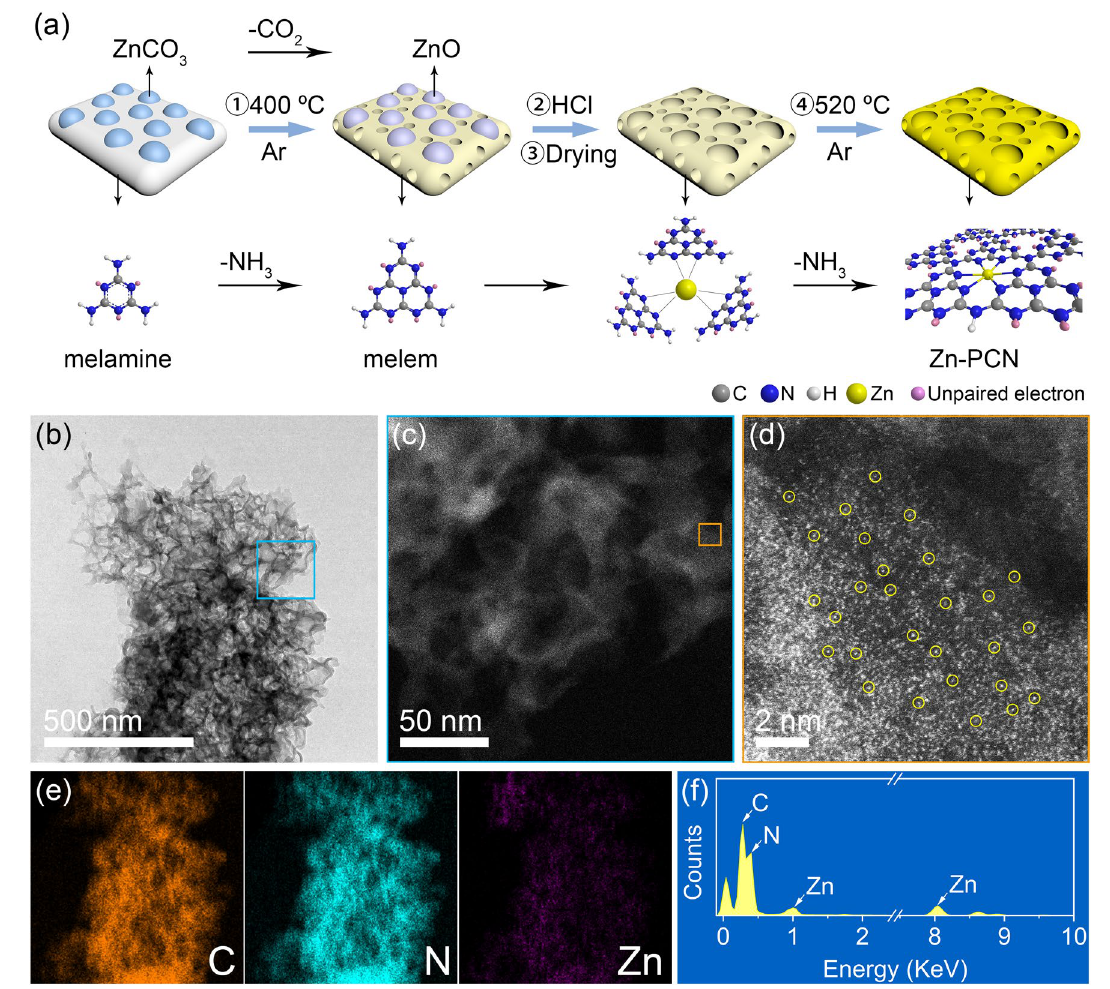
Fig. 1 a Schematic illustration of the synthesis of Zn‑PCN b TEM image of Zn‑PCN. Representative HAADF‑STEM images of Zn‑PCN at c low and d high magnifications zoomed in at the square regions in b and c , respectively. e Elemental mappings of C, N and Zn acquired from b . f EDS spectrum acquired from